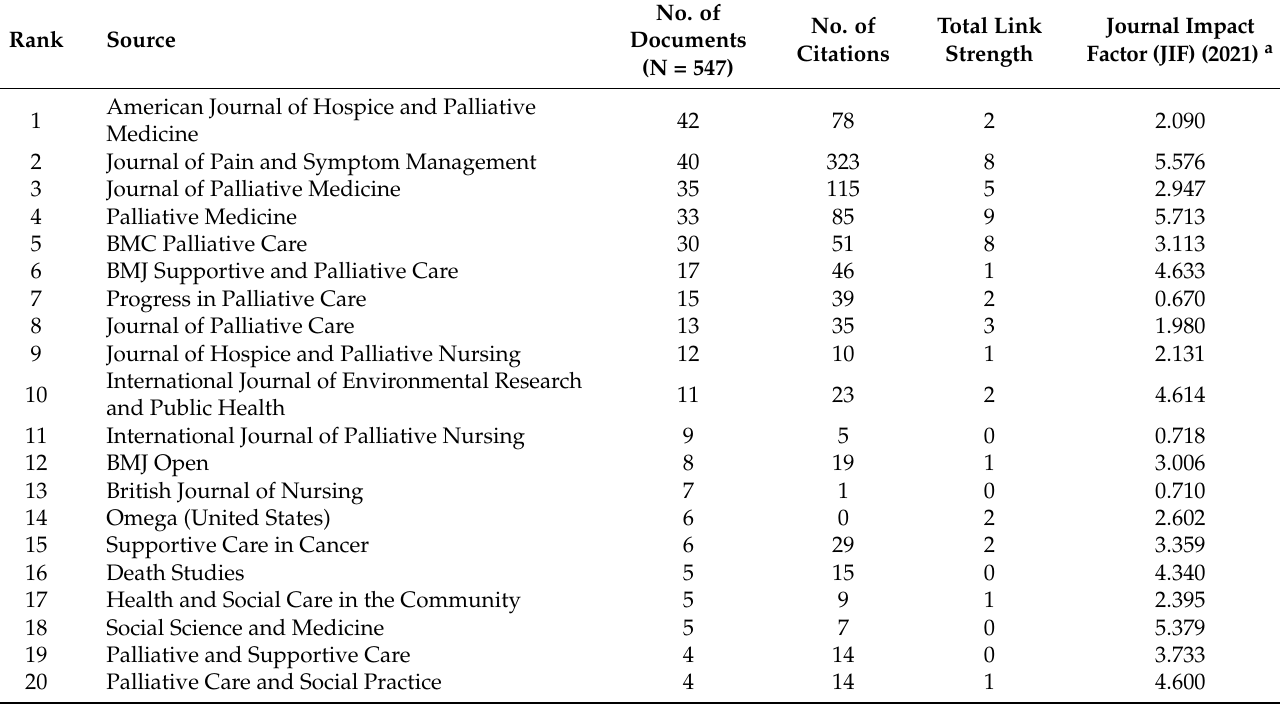
Table 5. Top 20 Journals where the most current relevant article publications on EoLC were published.